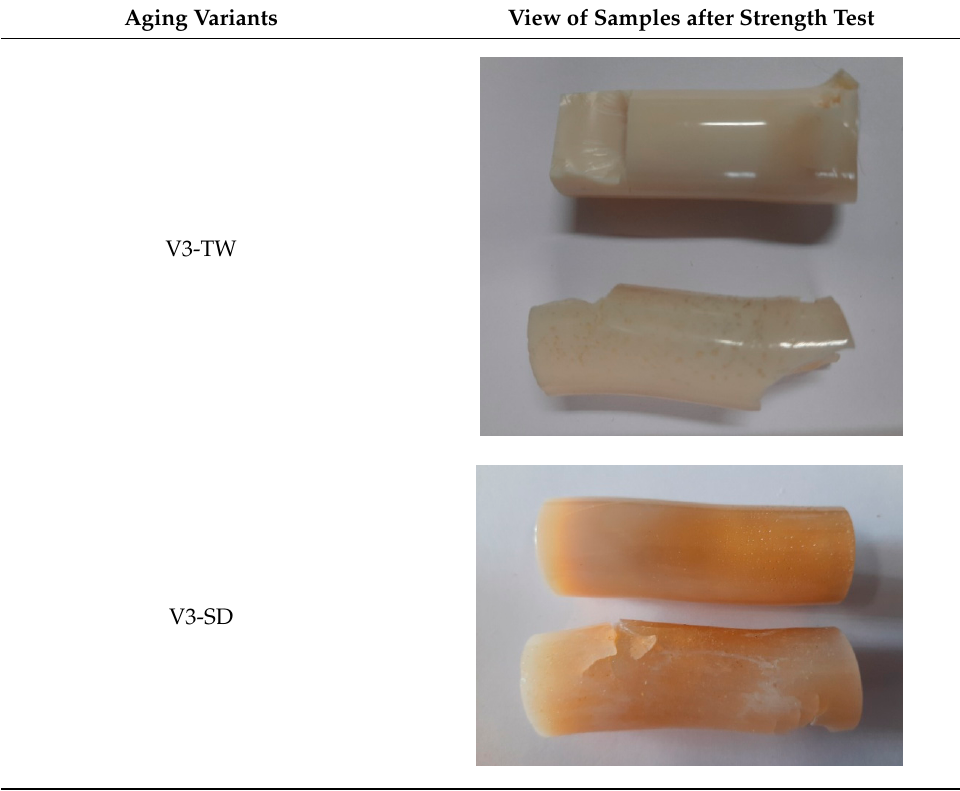
View of Samples after Strength Test V3-RW